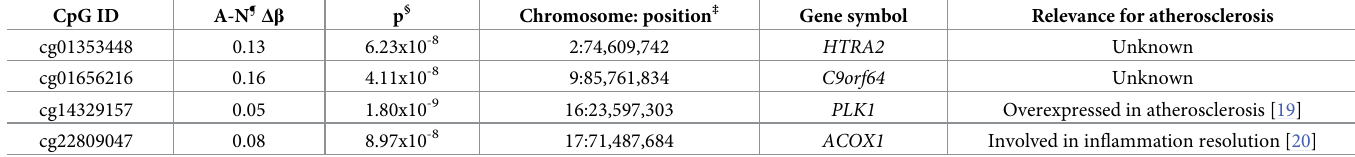
¶ A and N, atherosclerotic and healthy portion of the aorta, respectively. § Comparison of M-values, paired t-test, Bonferroni-corrected (threshold: p = 10 − 7 ). ‡ Genome build